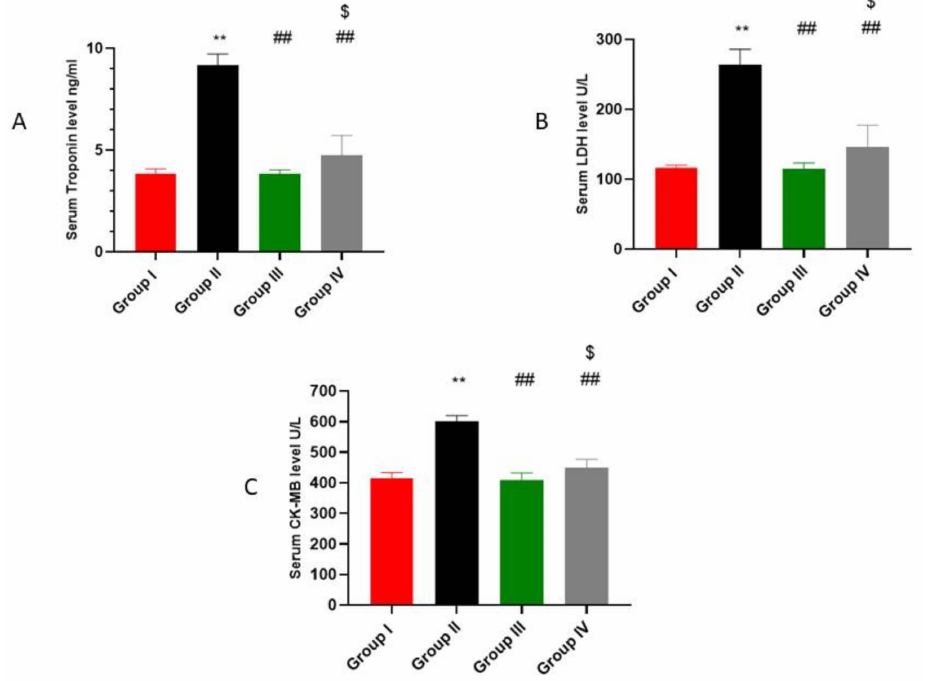
Figure 2. Effect of ADMSCs-derived exosomes on DOX/Trz-induced cardiac dysfunction: ( A ) Serum troponin level (ng/mL); ( B ) Serum lactate dehydrogenase (LDH) U/L; ( C ) Serum creatine kinase (CK-MB) U/L. Results are expressed as mean ± SEM. **, significant compared to Group I at p < 0.01; ##, significant compared to Group II at p < 0.01; $, significant compared to Group III at p < 0.05 ( n =